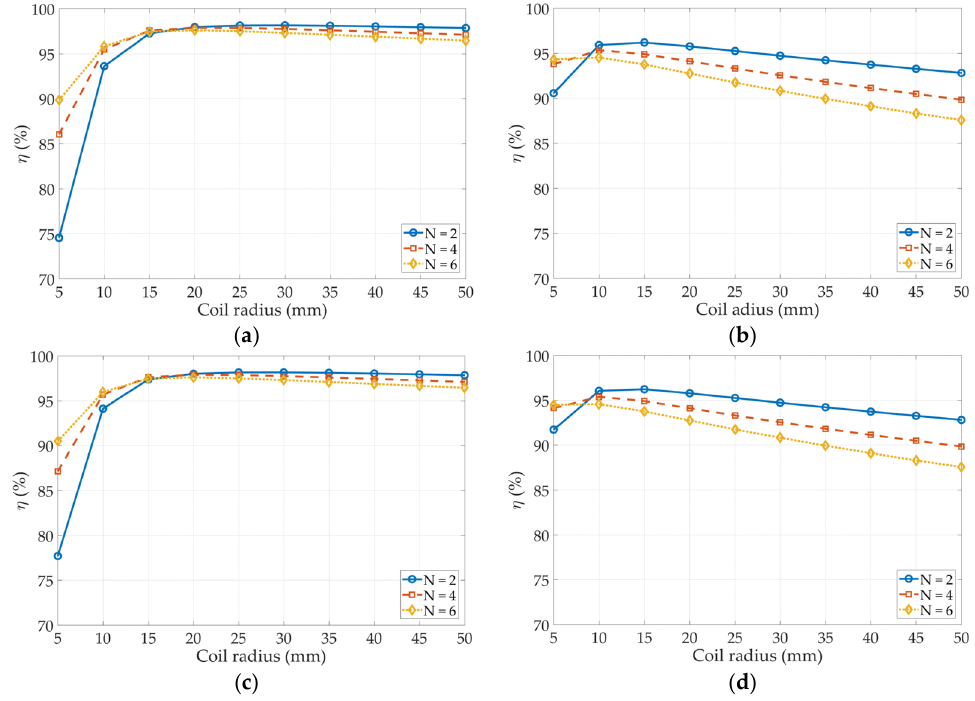
Figure 13. Power transfer efficiencies at various coil radii and numbers of turns for ( a ) S–S, ( b ) S–CCL, ( c ) CCL–S, and ( d ) CCL–CCL topologies.